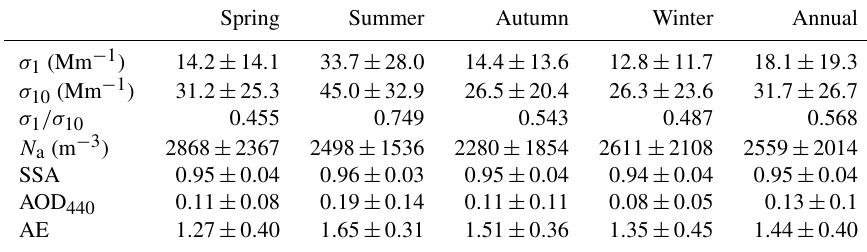
Table 1. Seasonally averaged aerosol properties during the campaign period. Spring Summer Autumn